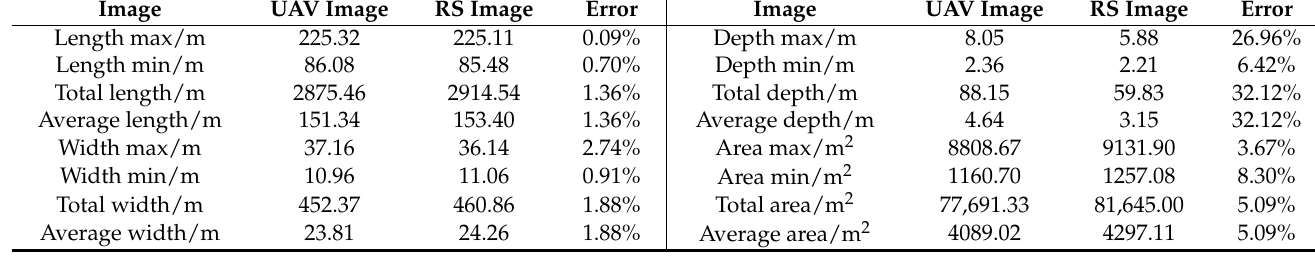
Table 1. Statistics on the morphological characteristics of gullies interpreted by UAV imagery and high-resolution RS imagery ( n = 19).